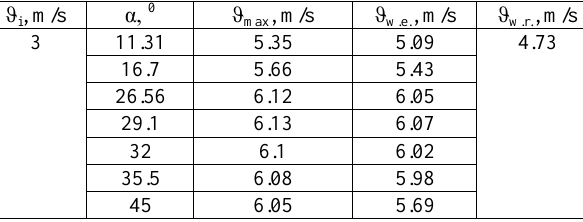
Figure 9. Diagram of airflow velocity contours in the absence of a building roof Table 1. The results of wind velocity in the zone of